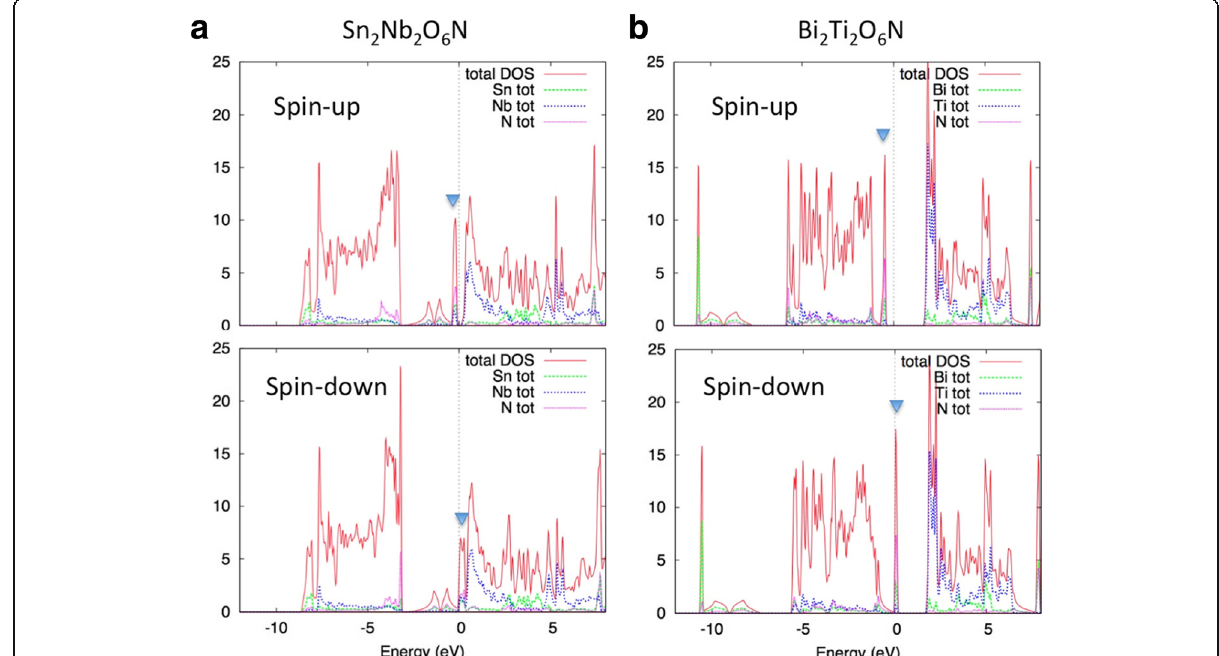
Fig. 3 DOS curve of ( a ) Sn 2 Nb 2 O 6 N and ( b ) Bi 2 Ti 2 O 6 N for spin-polarized state. Filled triangle shows the position of the quasi-flat